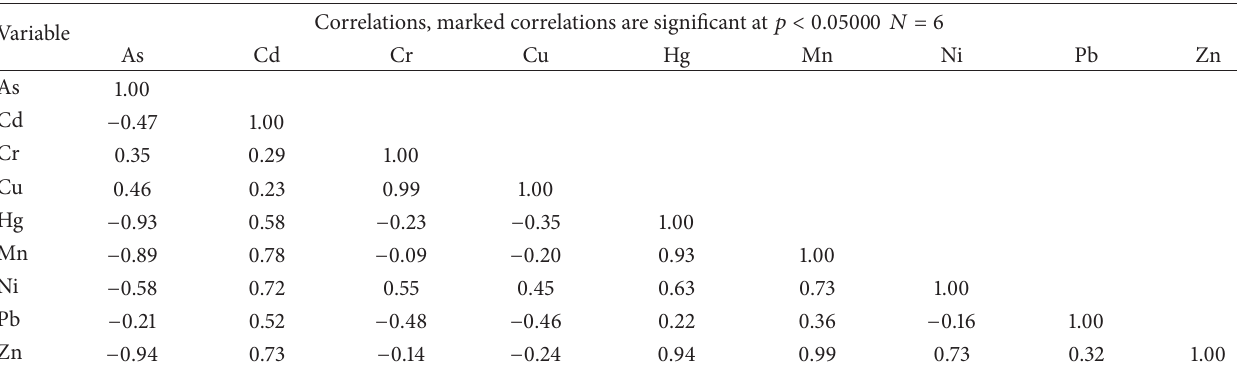
Table 6: Matrix of correlation coefficients ( 𝑟 ) of selected 9